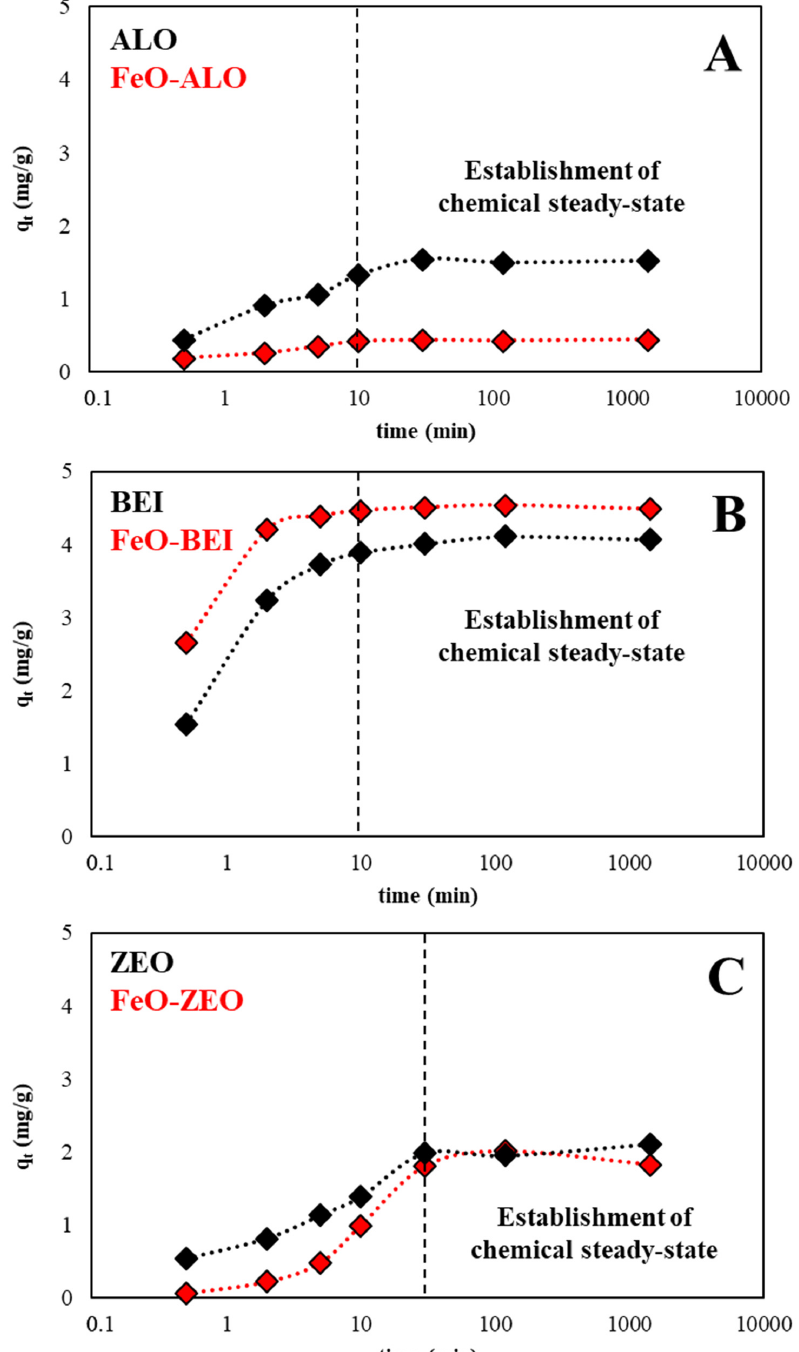
Figure 5. Kinetics experiments (operational conditions: 298 K, pH 6.0, adsorbate / adsorbent ratio: 500:1, 10 mg / L Ba). The e ff ect of contact time on the adsorption of aqueous Ba 2 + by natural and FeO-modified ALO ( A ), BEI ( B ) and ZEO ( C ) is shown.